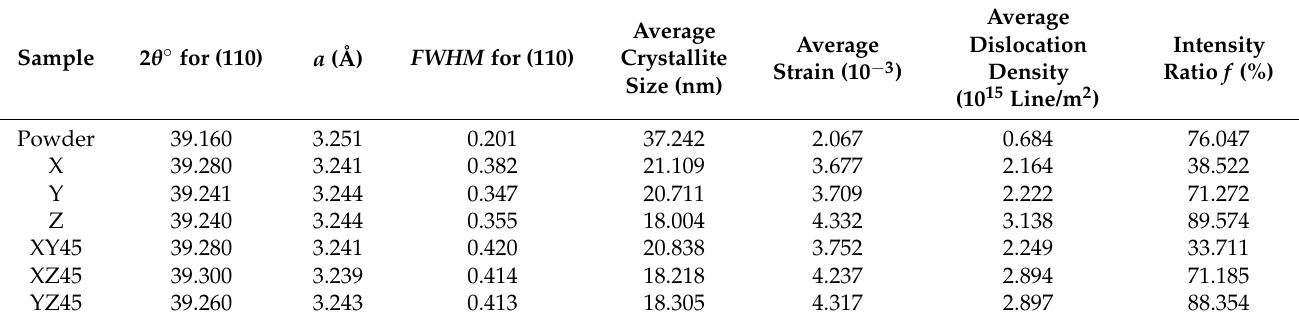
Table 5. The structural parameters of the β phase in as-fabricated